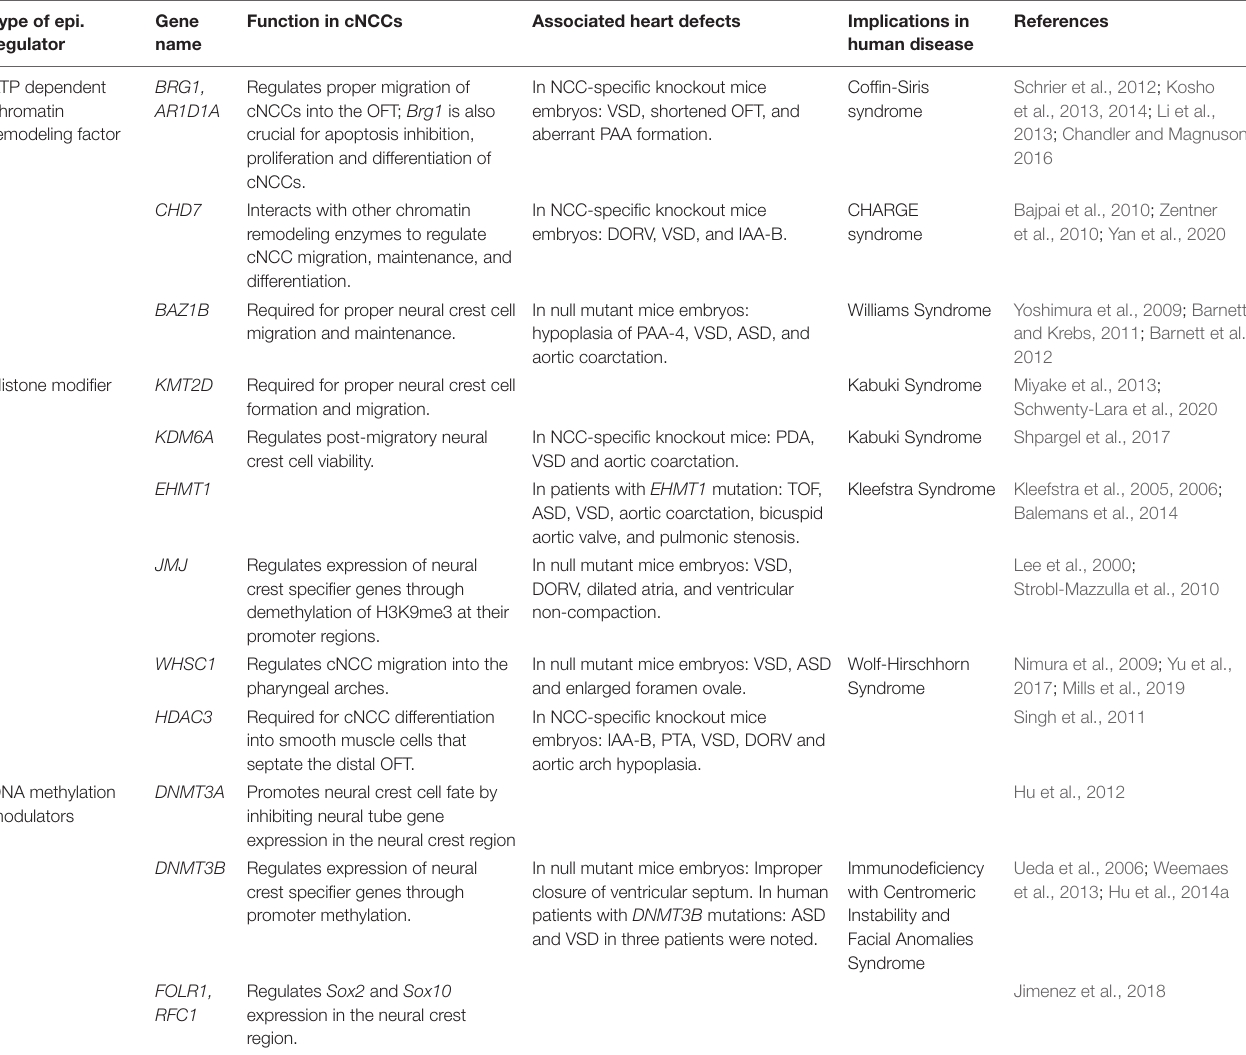
TABLE 1 | A summary of epigenetic regulators of cardiac neural crest cells (cNCCs). Type of epi.